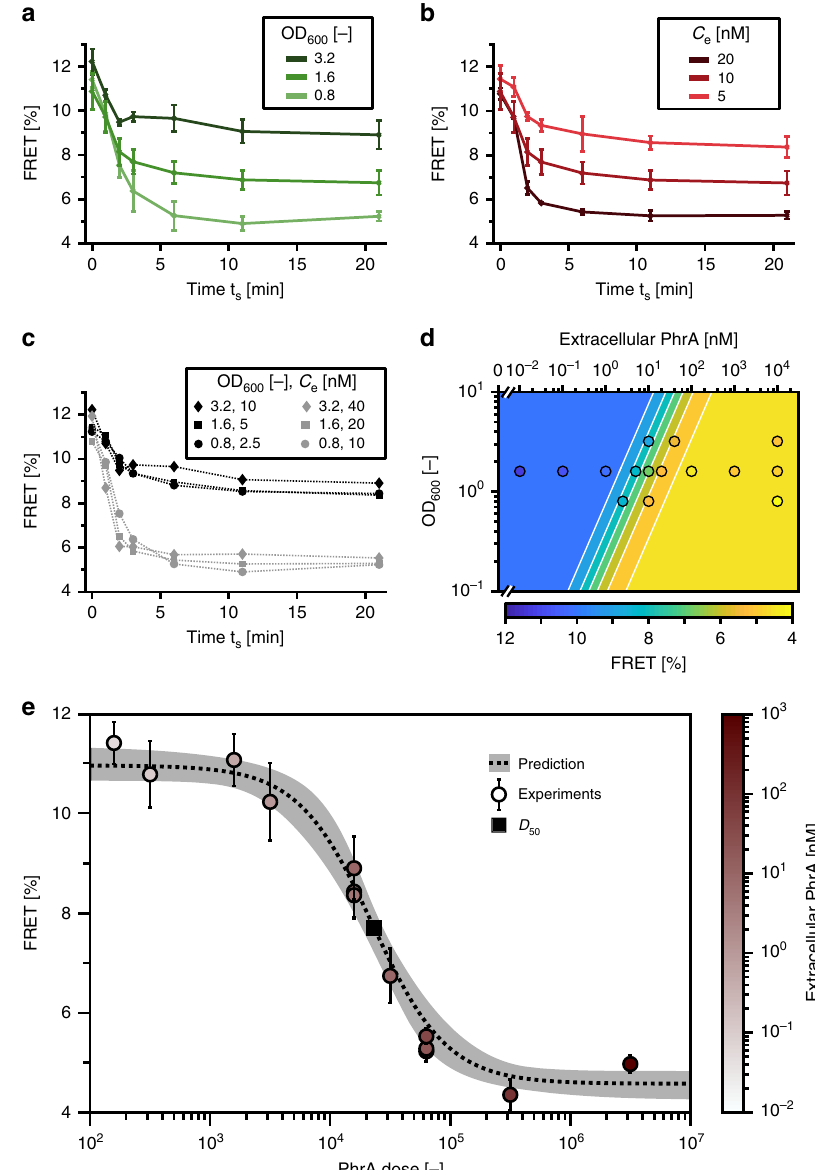
Fig. 7 The response to PhrA depends on the signal dose. a The FRET response of the population varies with cell density. Time course of stimulation with 10 nM PhrA for three different cell densities. Data: mean ± SD from n e = 3. b The FRET response varies with the extracellular concentration when cell density is fi xed (OD 600 ∼ 1.6). Data: mean ± SD from n e = 3. c Response curves using the indicated extracellular concentrations and cell densities, respectively. Proportional changes in both number of cells and extracellular concentrations, i.e., exposure of cells to the same dose, lead to very similar response curves. The response curves from different doses are distinct. d The contour plot of the lowest level of FRET as a function of cell density and the extracellular concentration of PhrA as predicted by the pump – probe model shows that variations in FRET require a change in the signal dose D . Filled circles denote experimental data. Color of circles indicates measured FRET values as set by the scale of the color bar on the bottom. e Dose – response curve: all of the minimal FRET values obtained from stimulation experiments with different extracellular concentrations collapse onto the predicted dose – response curve from the pump – probe model with a D 50 = 2.4 × 10 4 molecules. Color of circles depict extracellular concentrations used in the experiment according to the scale of the color bar on the right. Source data for all panels are provided as a Source Data fi